Question: Looking at the figure, what chart type is it?
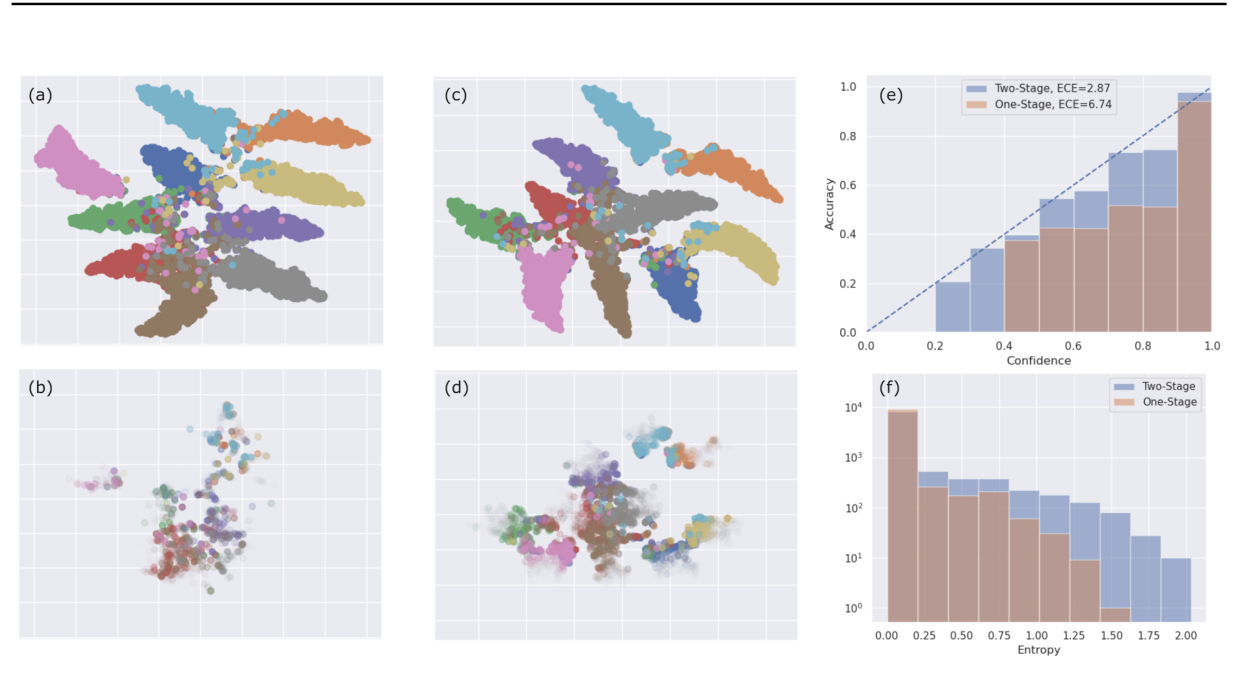
Answer: scatter